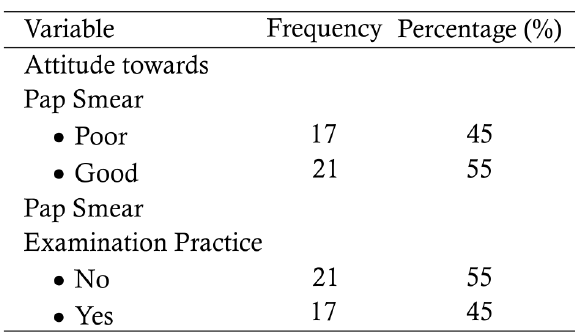
Frequency Distribution of Attitude and Pap Smear Examination